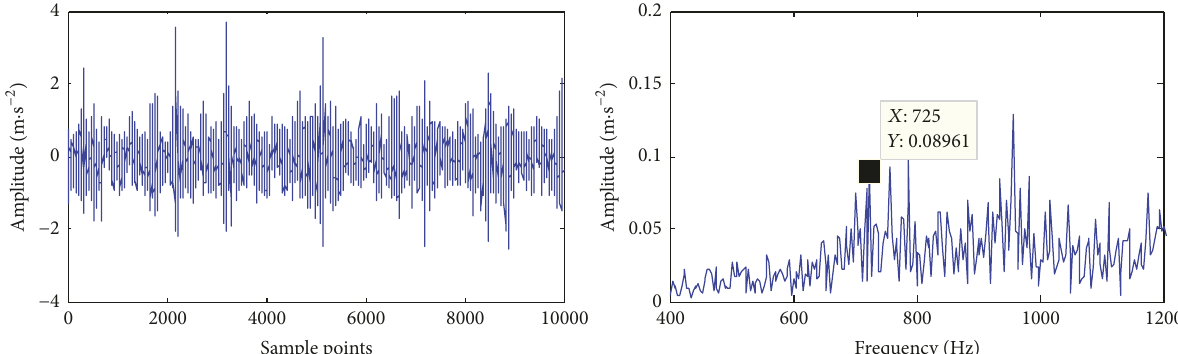
Figure 18: The experimental time domain signal and frequency domain signal.